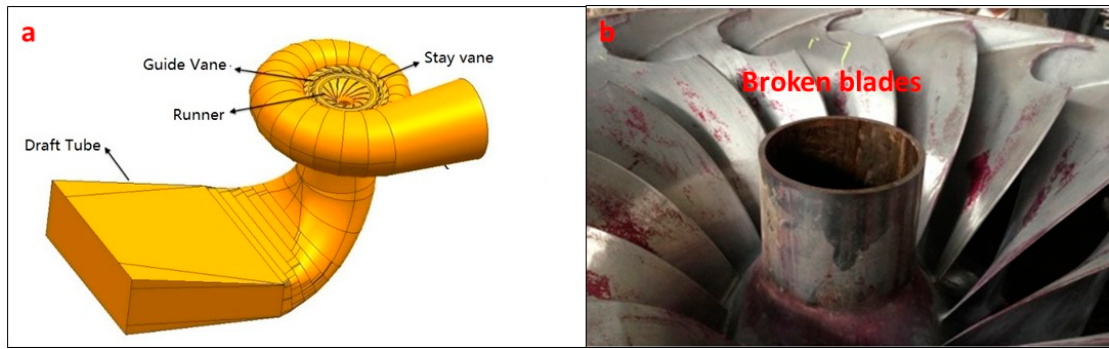
Figure 1. ( a ) Main components of the Francis Turbine and ( b ) the bottom view of the Francis turbine with broken trailing edges in some blades.